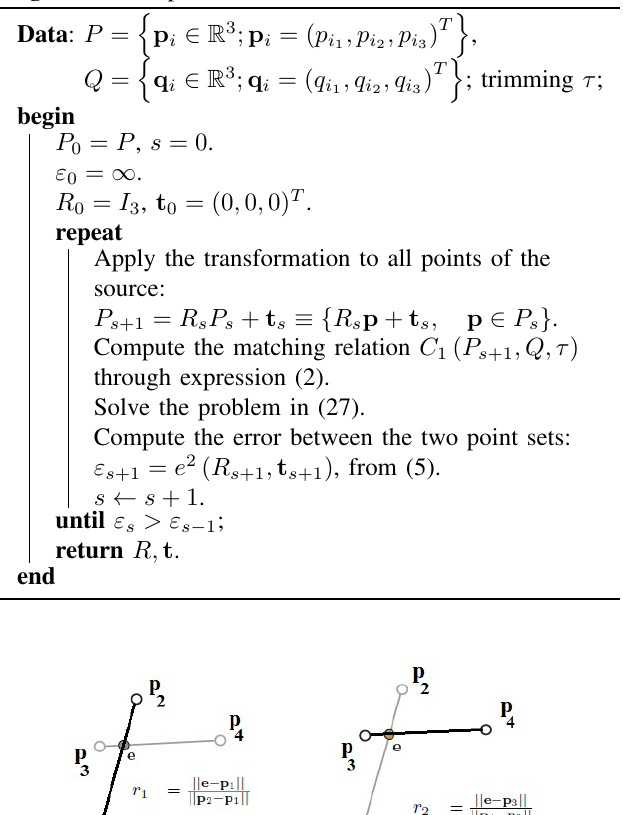
Algorithm 4: Sparse ICP Method